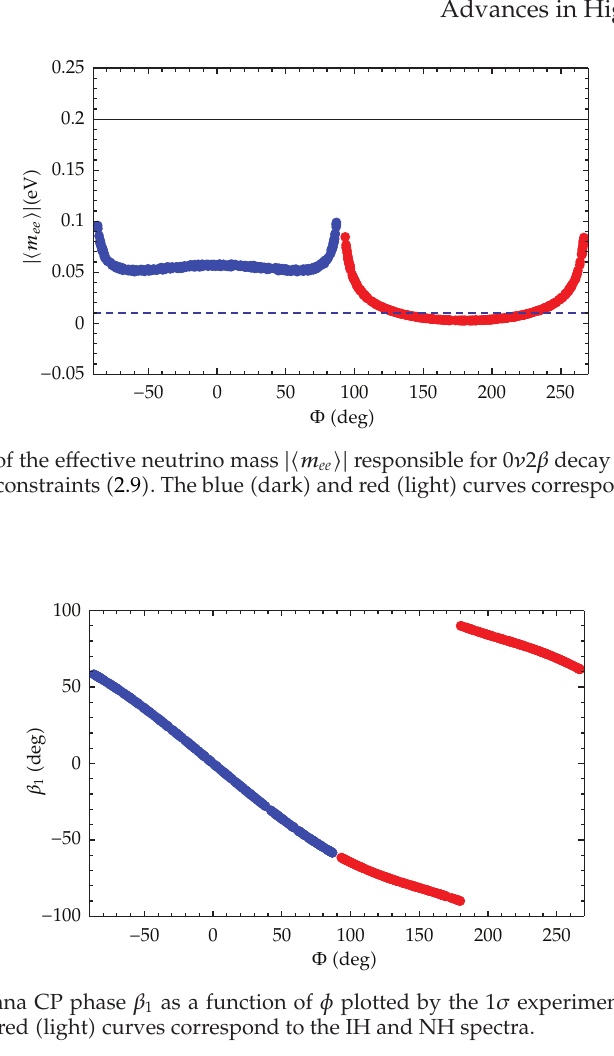
Using (cid:2) 10 (cid:3) we can obtain the explicit relation between φ and β 1 :